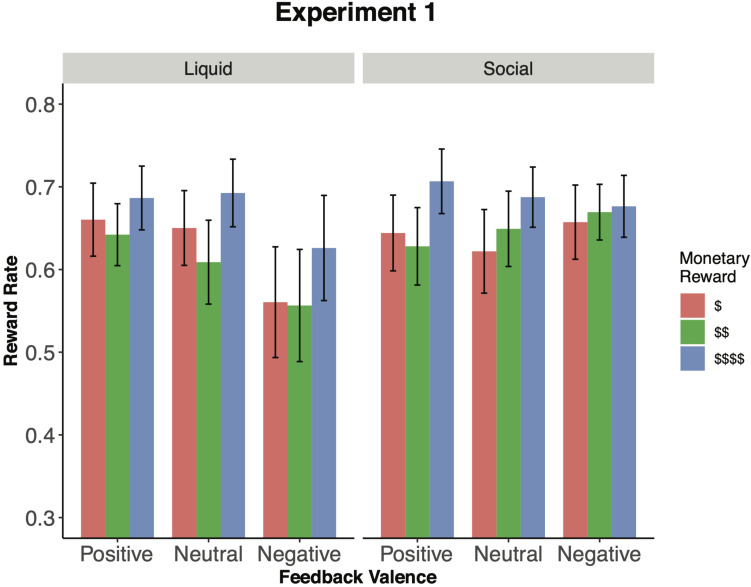
Incentive integration effects by experimental manipulation (Experiment 1). The figure shows reward rate by monetary reward level and feedback (i.e., liquid, social). Participants showed a main effect of monetary reward and feedback during the liquid feedback session. However, there was only a main effect of monetary reward, but not feedback during the social feedback session. Error bars represent 95% confidence intervals around the mean.